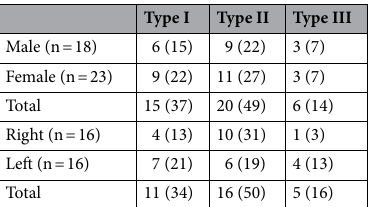
Table 1. Comparison of IFP classifications by sex and laterality. Values are reported as number of specimens (%).